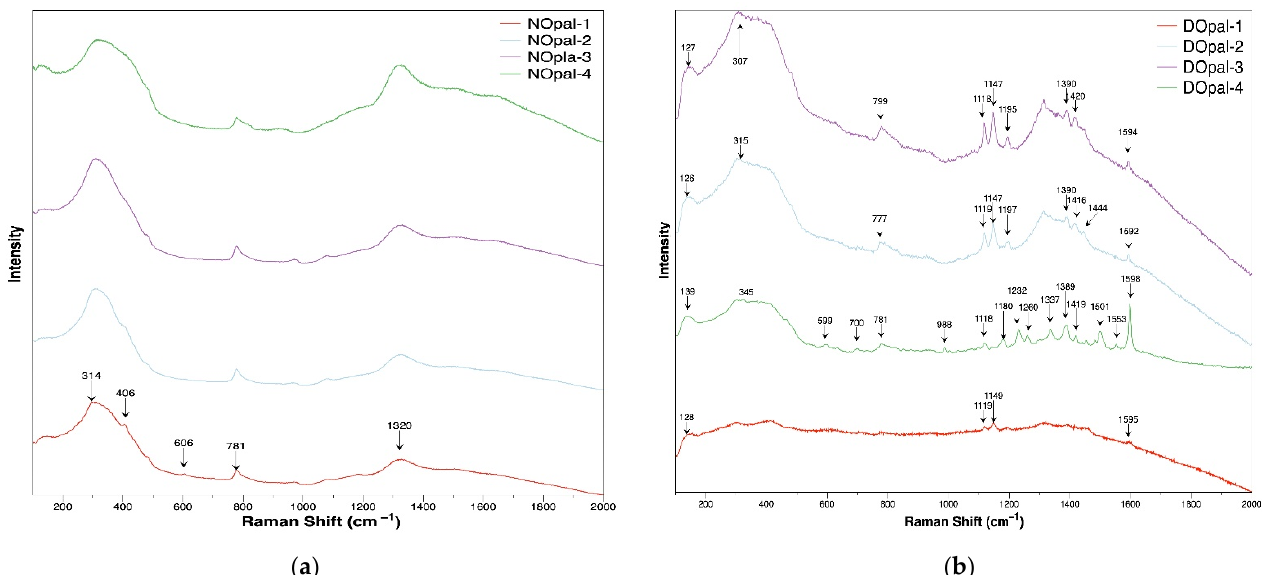
Figure 8. Raman spectra of samples at 785 nm laser: ( a ) natural opals; ( b ) dyed opals.